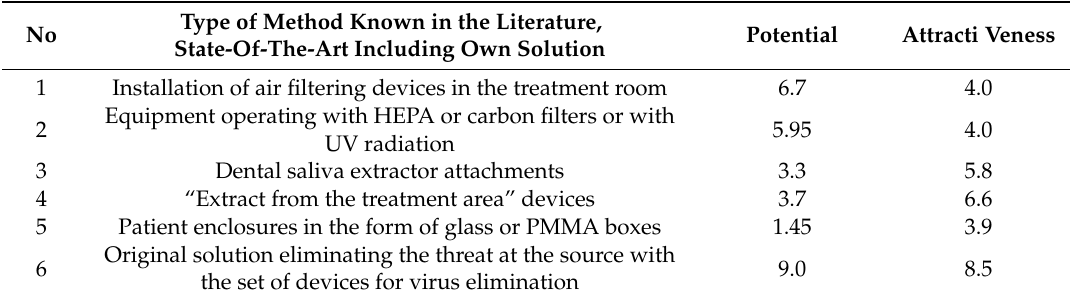
Table 2. The results of calculating the potential and attractiveness of groups of methods of protection against the e ff ects of SARS-CoV-2